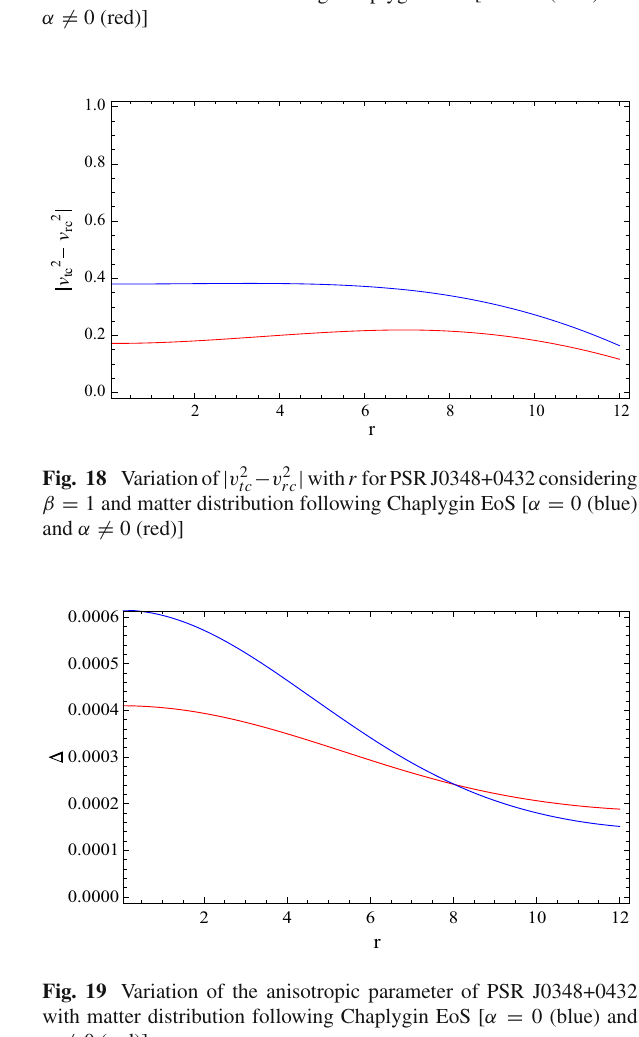
cal value of radius ( r = 8 . 02 km for PSR J0348+0432) at which the value of Δ for α = 0 and α (cid:5)= 0 coin-